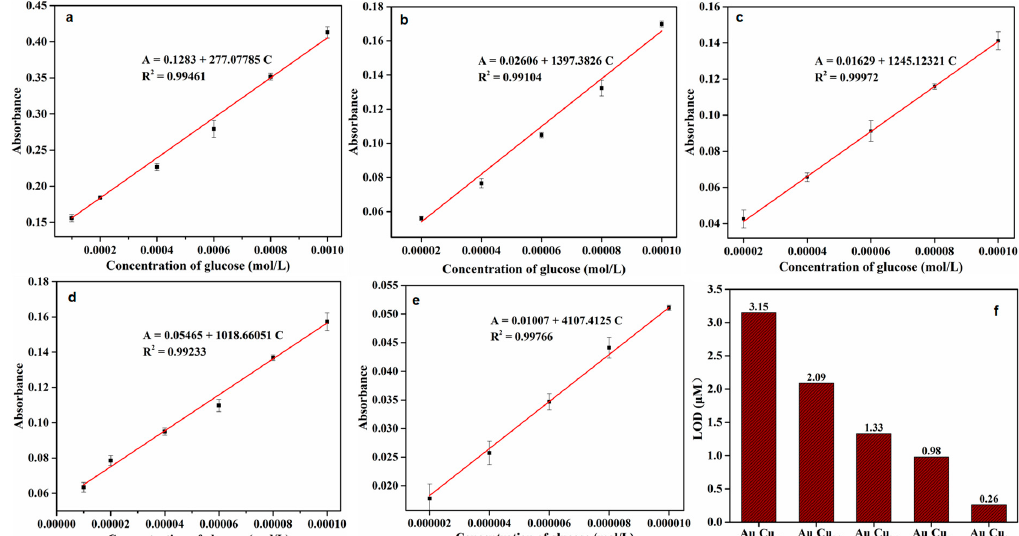
Figure 8. ( a – e ) Dose-response curves for glucose detection using ( a ) Au 1 Cu 0.1 , ( b ) Au 1 Cu 0.2 , ( c ) Au 1 Cu 0.5 , ( d ) Au 1 Cu 1 , and ( e ) Au 1 Cu 2 as peroxidase mimetics. Inset of a – e : Linear range of absorbance intensity versus H 2 O 2 concentration. ( f ) Limit of detection (LOD) for glucose of Au 1 Cu 0.1 , Au 1 Cu 0.2 , Au 1 Cu 0.5 , Au 1 Cu 1 , and Au 1 Cu 2 nanoparticles. Table 2. Analytical parameters of glucose detection in recent papers.